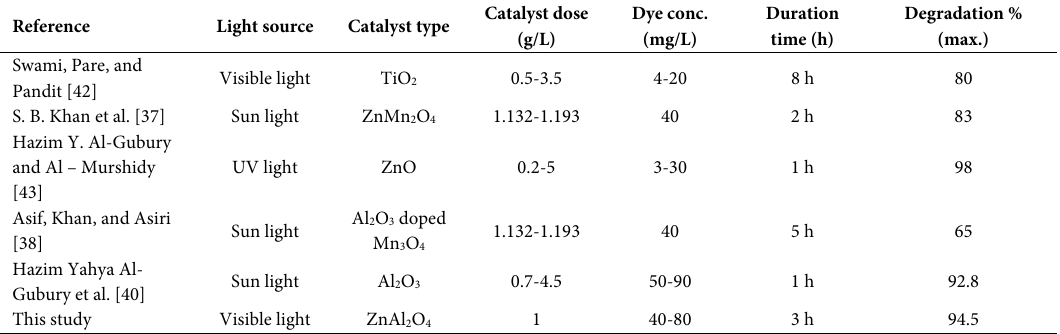
Table 3. summarizes the published literature articles on the photocatalytic degradation of brilliant cresyl blue dye